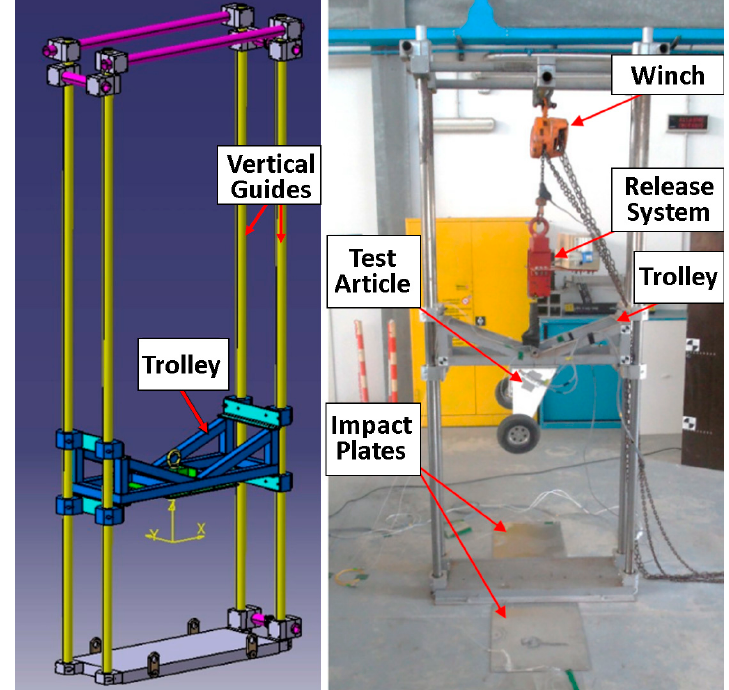
Figure 2. Test article’s overall dimensions.